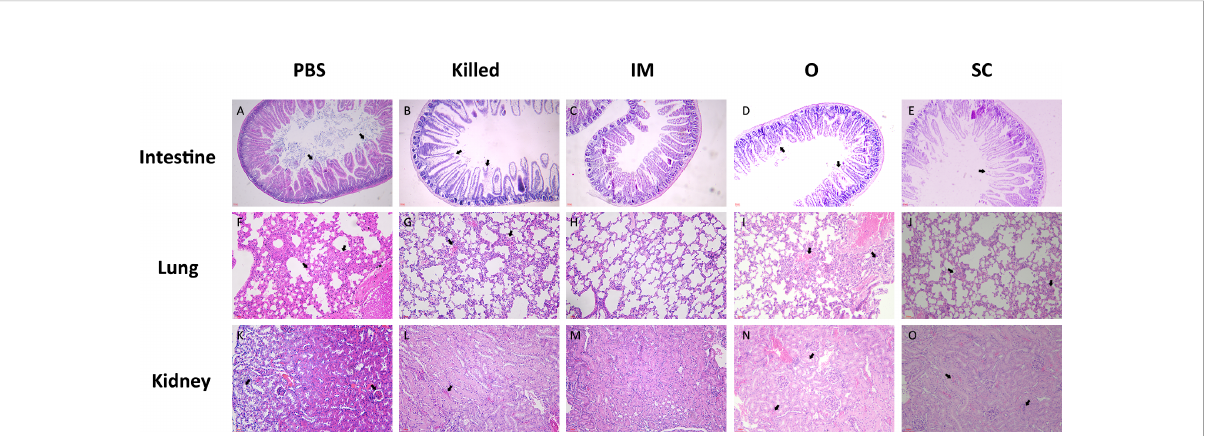
FIGURE 6 Pathological histological evaluation of intestine (A – E) , lung (F – J) and kidney (K – O) of mice in the PBS, Killed, IM, O and SC group at 7 days post-challenge. Intestinal villi (40×), alveoli (100×), and renal cortical structures (100×) were severely damaged in the PBS group. In the Killed group, Intestinal villi, alveoli structures were moderate damaged, while the renal cortical was mild damaged. Almost no damage appeared in the tissues of IM group. In the O group, intestinal villi showed mild injury, whereas moderate pulmonary and kidney lesions were observed. SC group showed engorged alveolar capillaries and peritubular capillaries.